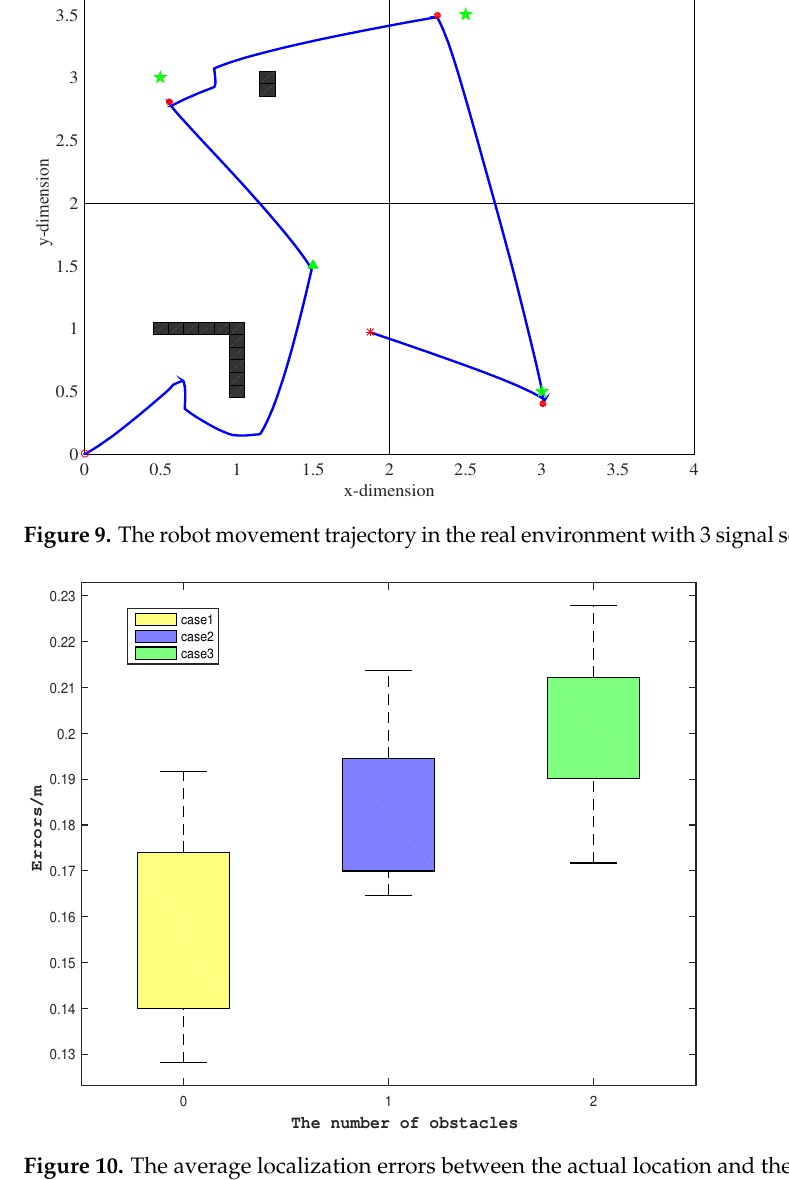
Figure 10. The average localization errors between the actual location and the estimated